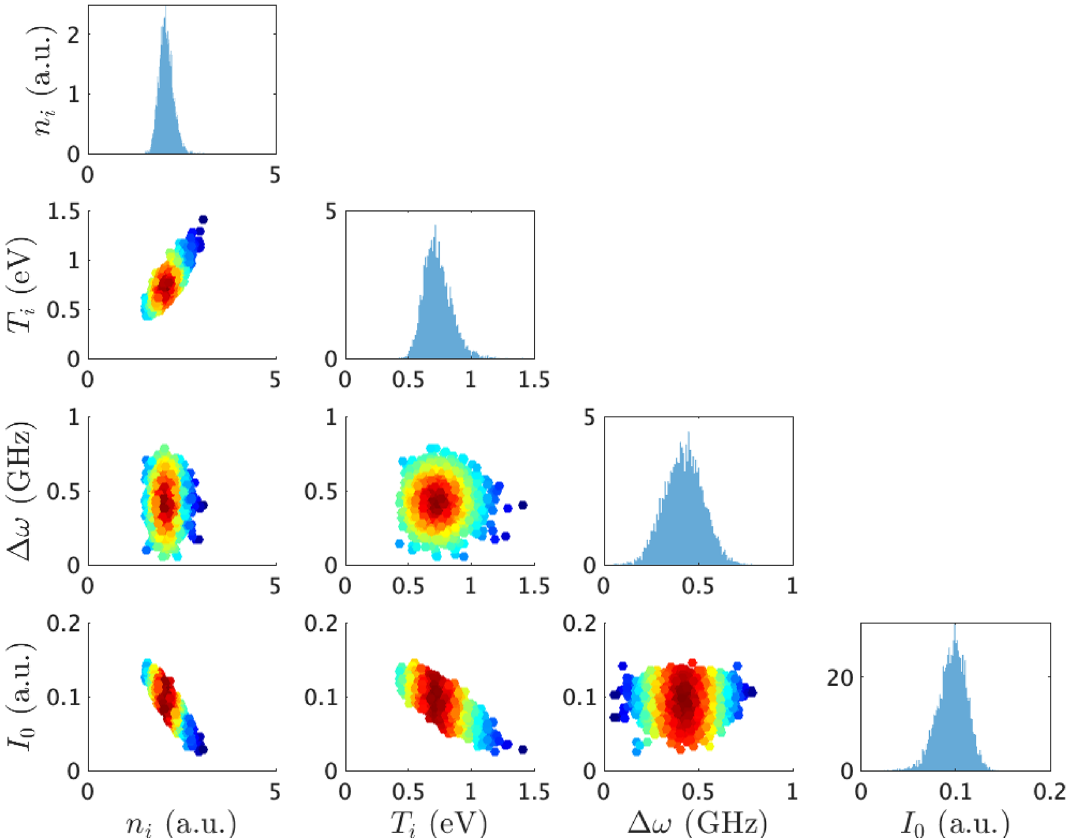
Figure 4. Corner plot of posterior probability density under the assumption of function III. The panels on the diagonal show the histogram as the posterior probability density for each parameter, obtained by marginalizing over the other parameters. The off-diagonal panels show the scatter plots as the posterior probability distributions for each pair of parameters. The colour of each dot represents posterior probability density on each